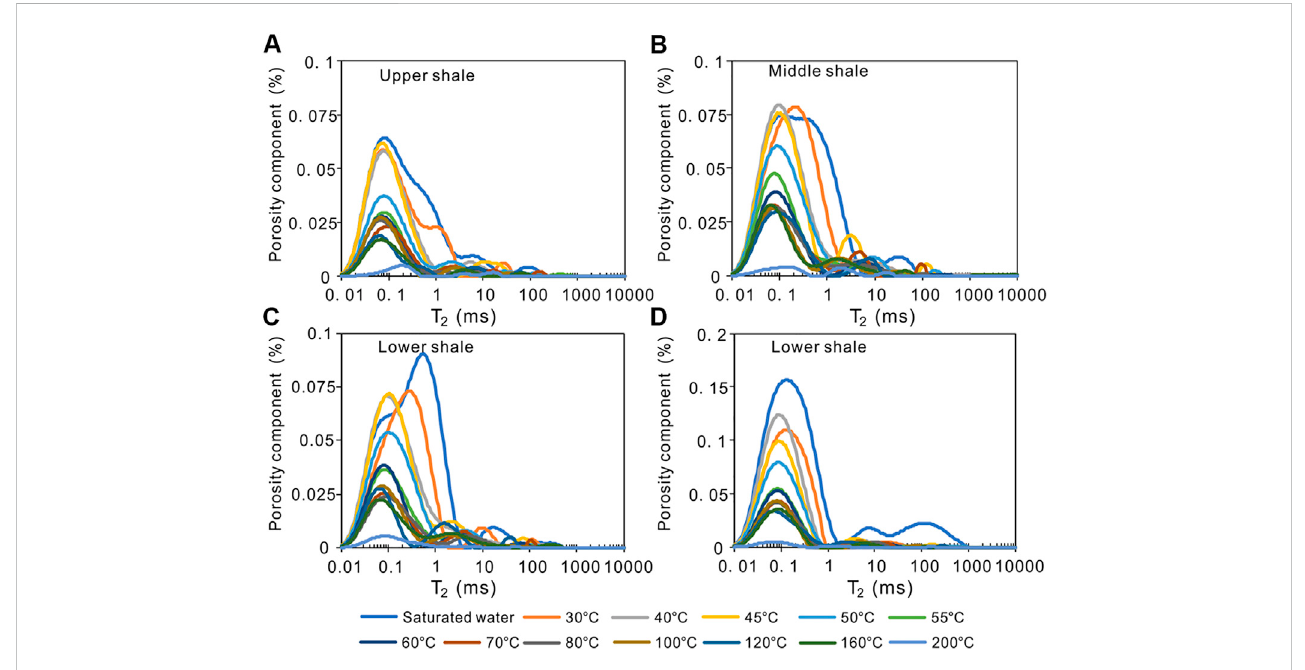
FIGURE 5 NMR T 2 spectra of Shan2 3 Submember transitional shale at different drying